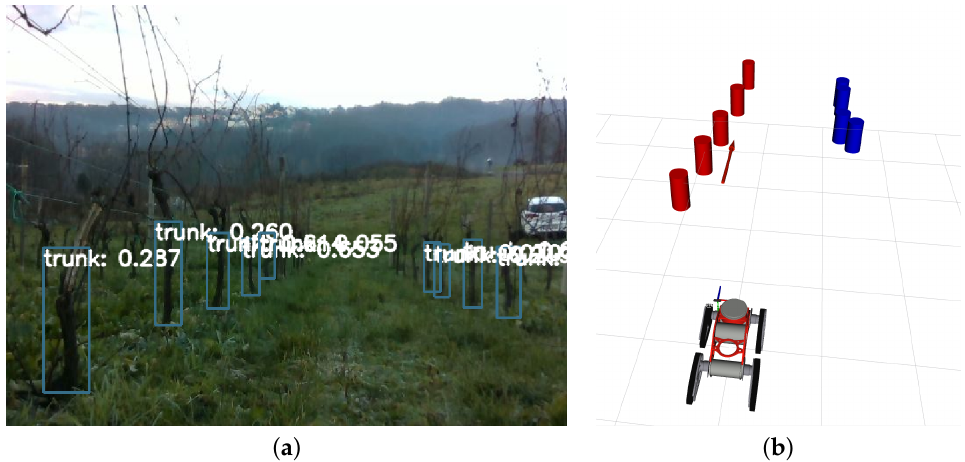
Figure 12. An image input for the detection and the estimated positions of the vine trunks around the ATMM-VIV. The red arrow is the desired goal position for the robot to perform the given task. ( a ) Animage input for the detection. ( b ) Estimated